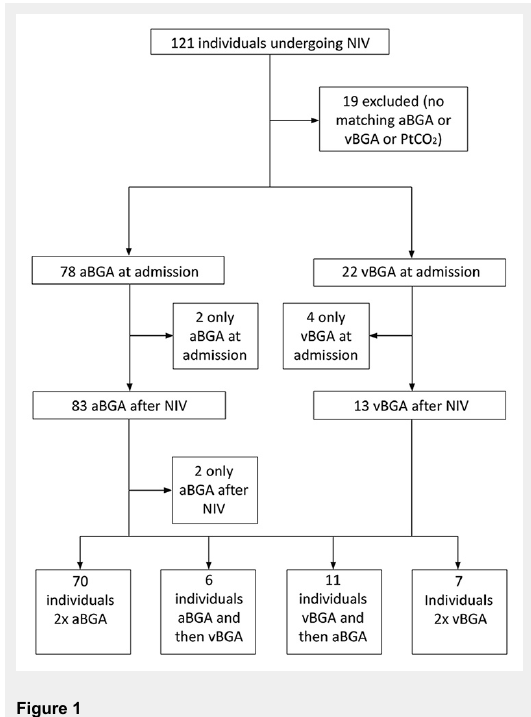
Study flow diagram. aBGA = arterial blood gas analysis; NIV = noninvasive ventilation; PtCO 2 = transcutaneous partial pressure of CO 2 ; vBGA = venous blood gas analysis